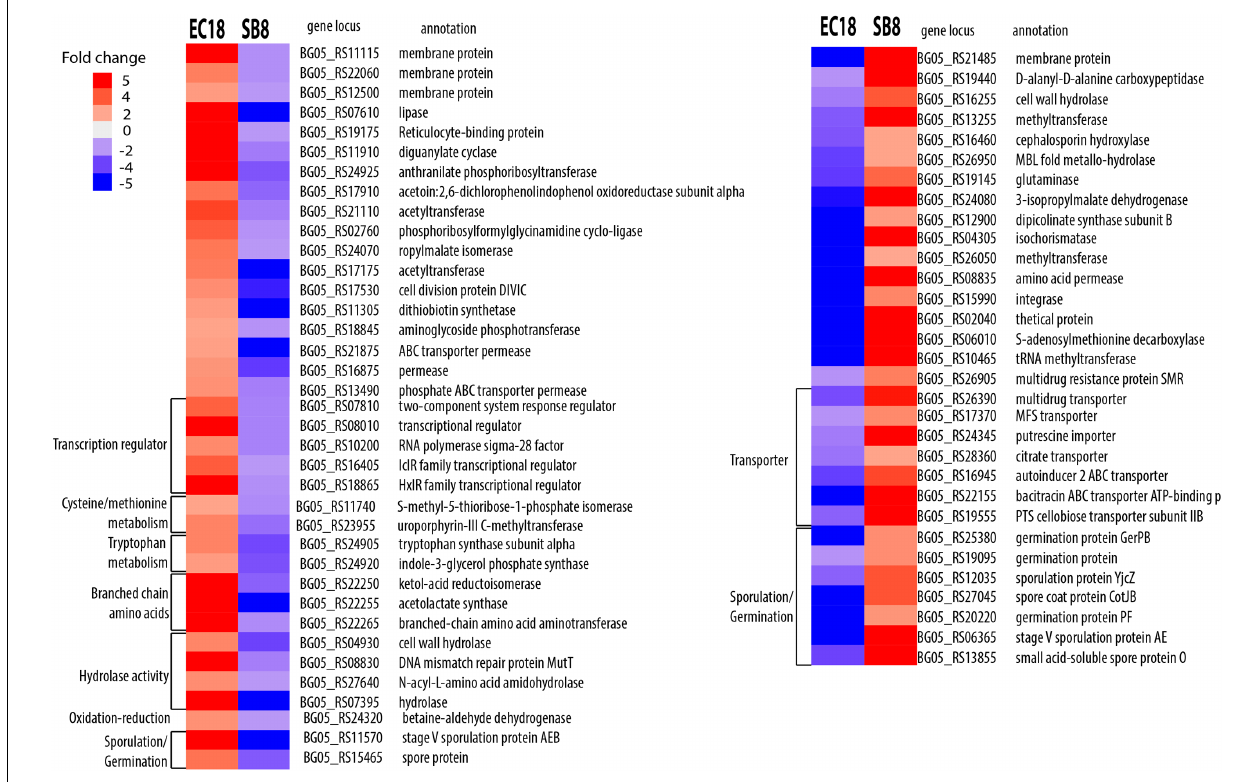
FIGURE 6 | Differentially expressed genes show opposite trends in B. mycoides strain EC18 and SB8 in response to root exudates. Red represents significant upregulation and blue indicates significant downregulation of gene